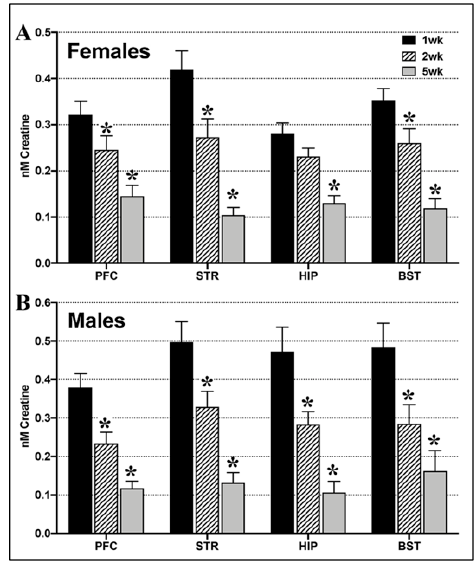
Figure 1. Brain creatine levels decrease with duration at moderate altitude in both sexes. ( A ). In females, brain creatine decreased from 1 week at altitude (4500 ft) to be significantly lower at 2 weeks and 5 weeks in the PFC, STR, HIP and BST. ( B ). In males, brain creatine also decreased from 1 week to be lower at 2 weeks and 5 weeks at altitude in all 4 brain regions. (One-way ANOVA, * = p < 0.05 vs. 1 week).